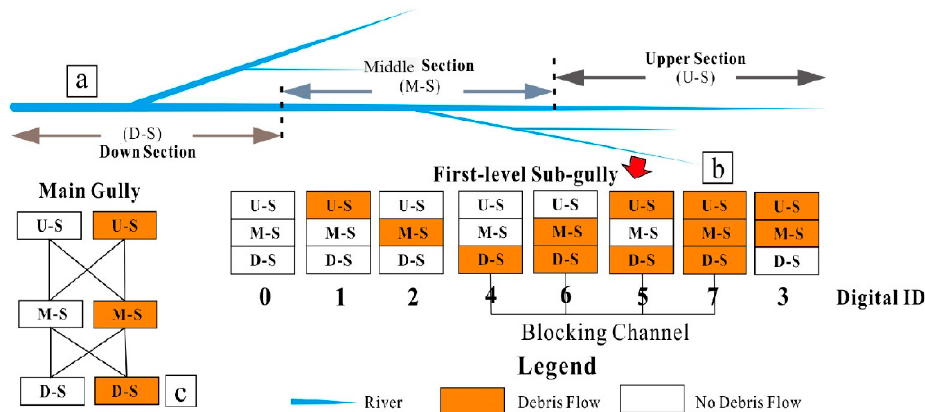
Figure 5. “Three-section method (TSM)” of debris flow gully classification. ( a ) Three sections of one gully, including U-S, M-S and D-S; ( b ) Debris flows in different sections of the first-level sub-gully; ( c ) Debris flows in different sections of the main gully. Some sections of gullies where debris flows occur are marked in brown. Considering the occurrences of debris flows at different locations in the gullies, eight combinations can be obtained.